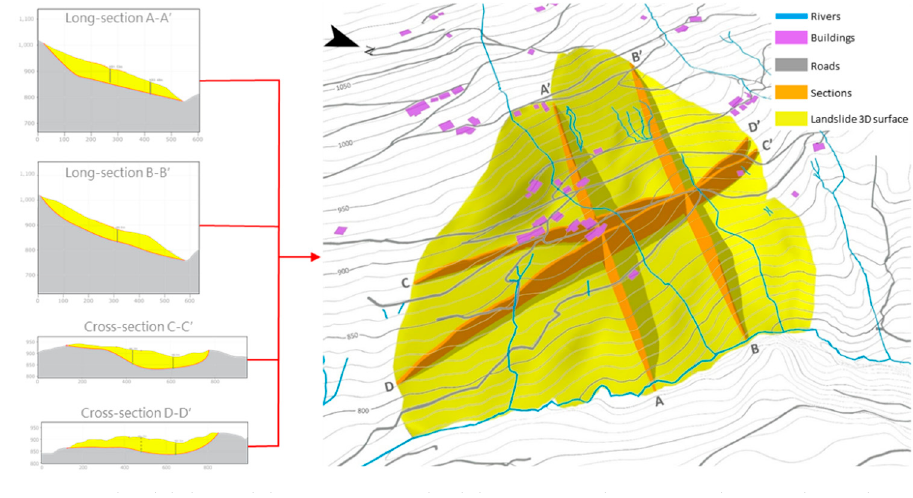
Figure 14. 3D landslide model reconstruction built by merging the previously VIM ‐ derived sections.